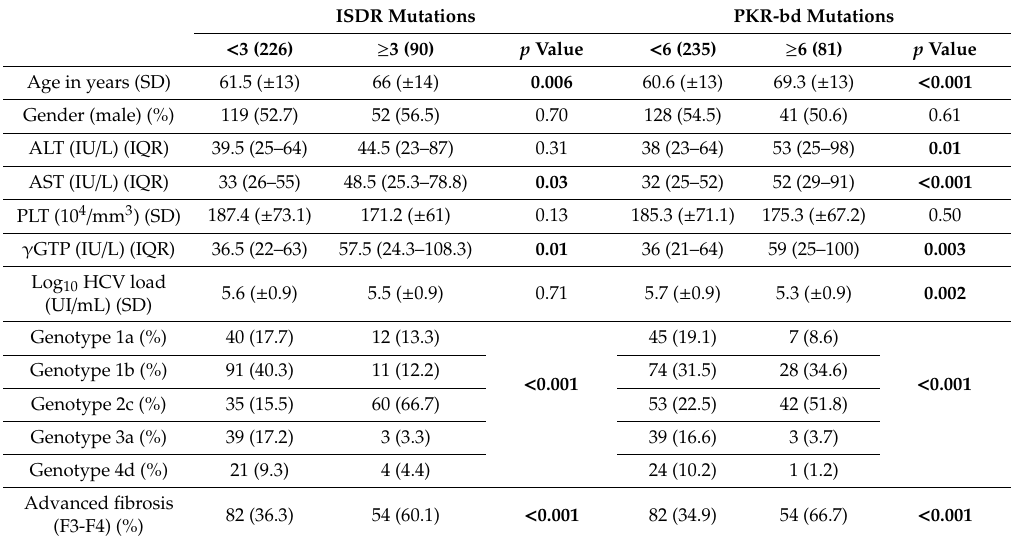
Table 2. Clinical characteristics according to the number of substitutions in the ISDR and PKR-bd.